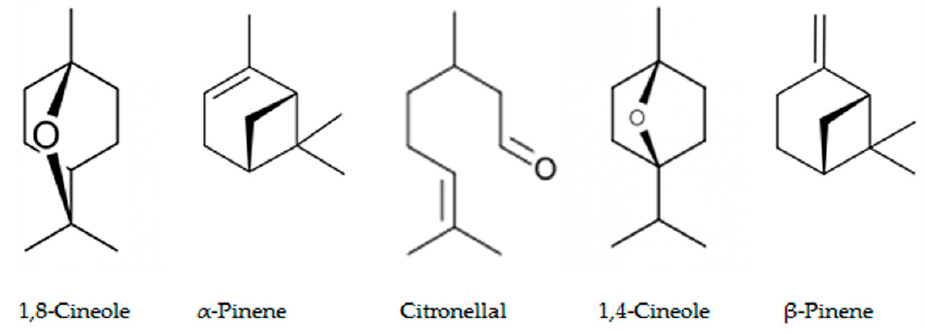
Figure 8. Components of the Eucalyptus essential oils.